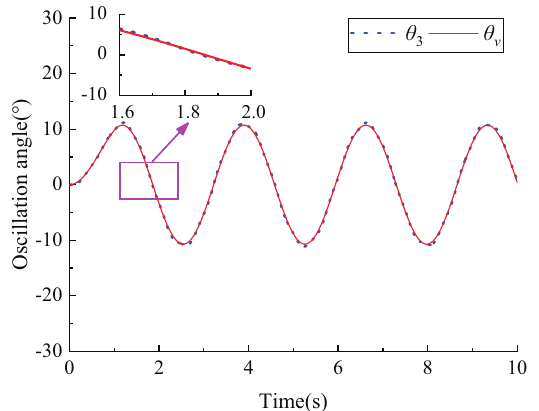
Figure 4. Oscillation response of the double pendulum crane with the DMP and the equivalent single pendulum